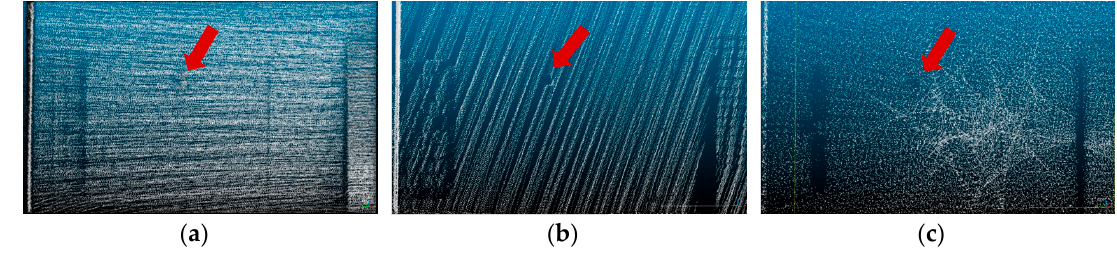
Figure 18. Three datasets with a 14.5 cm-diameter sphere, pinpointed by the arrow, attached to a wall: ( a ) Kaarta Stencil; ( b ) Leica Pegasus Backpack; ( c ) GeoSlam Zeb-Revo.